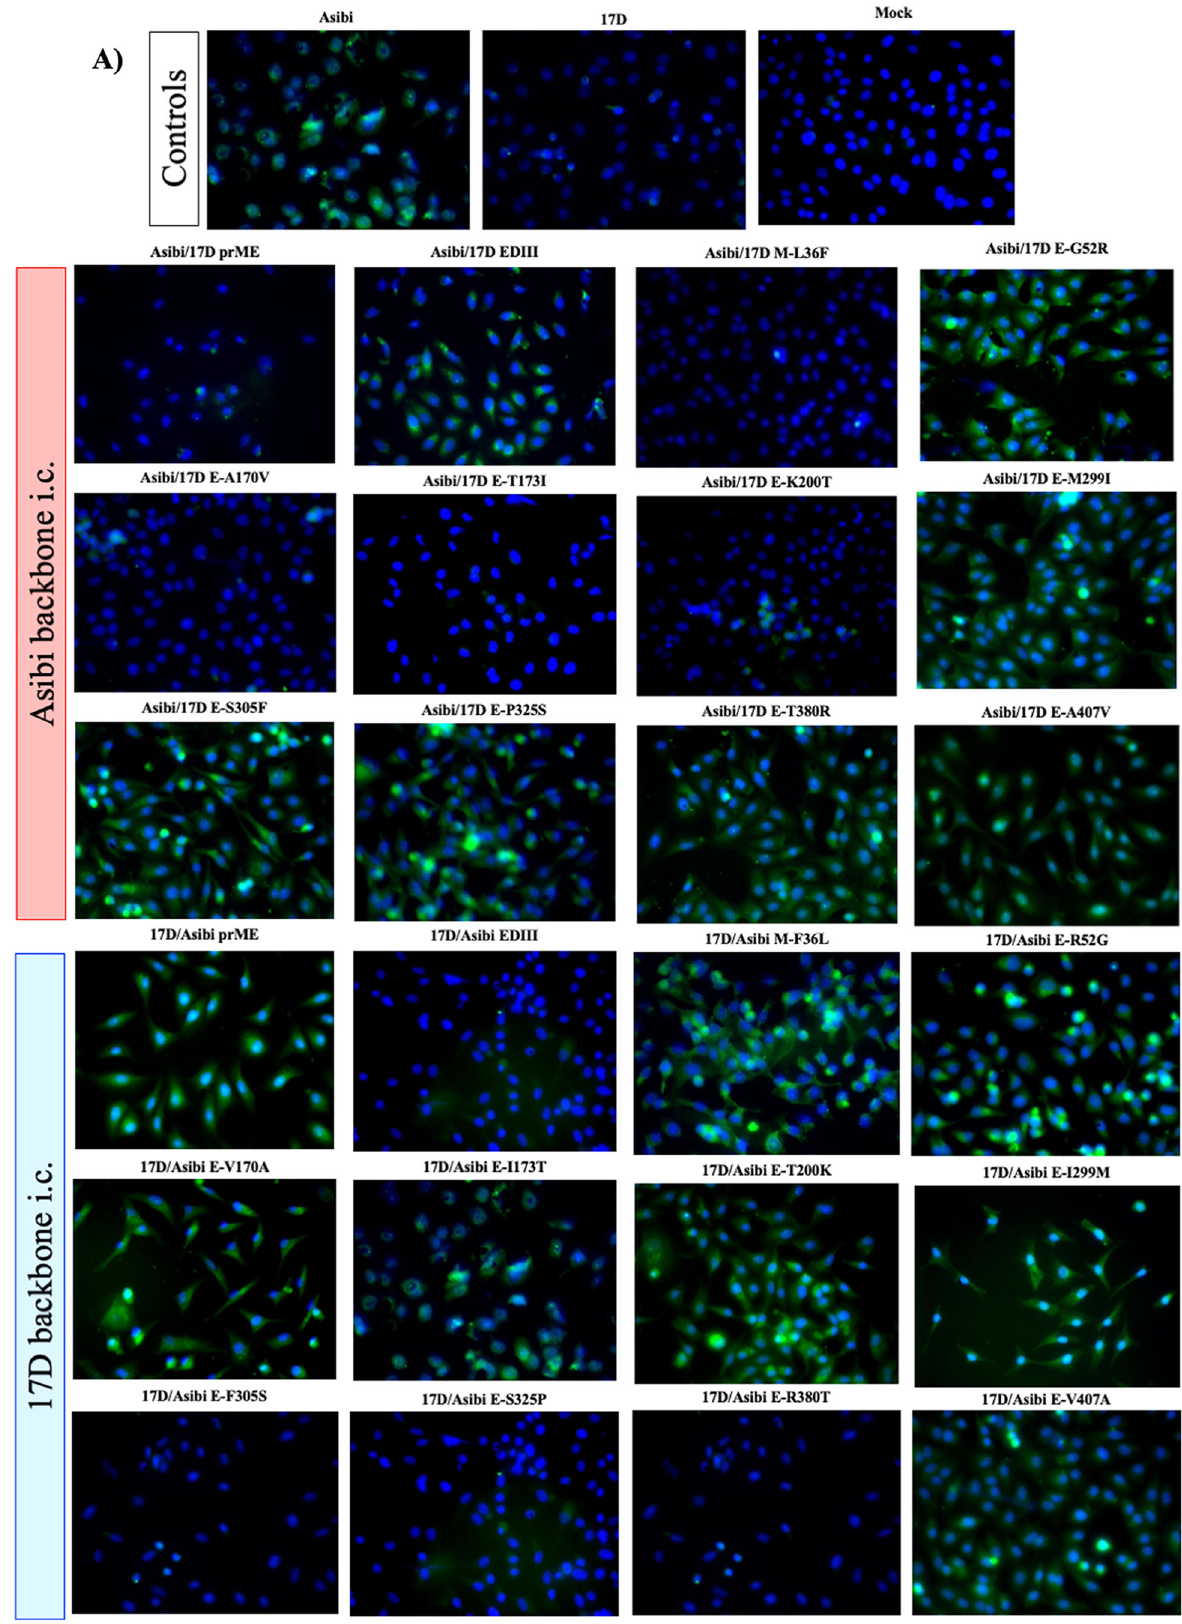
Fig. 2 Structural genes of YFV are responsible for binding of YFV to WT-speci fi c mAb 117 and vaccine-speci fi c mAb 411. The WT epitope of mAb 117 was mapped using YFV structural chimeras of Asibi and 17D viruses ( A ). The WT epitope of mAb 411 was mapped using YFV structural chimeras of Asibi and 17D viruses ( B